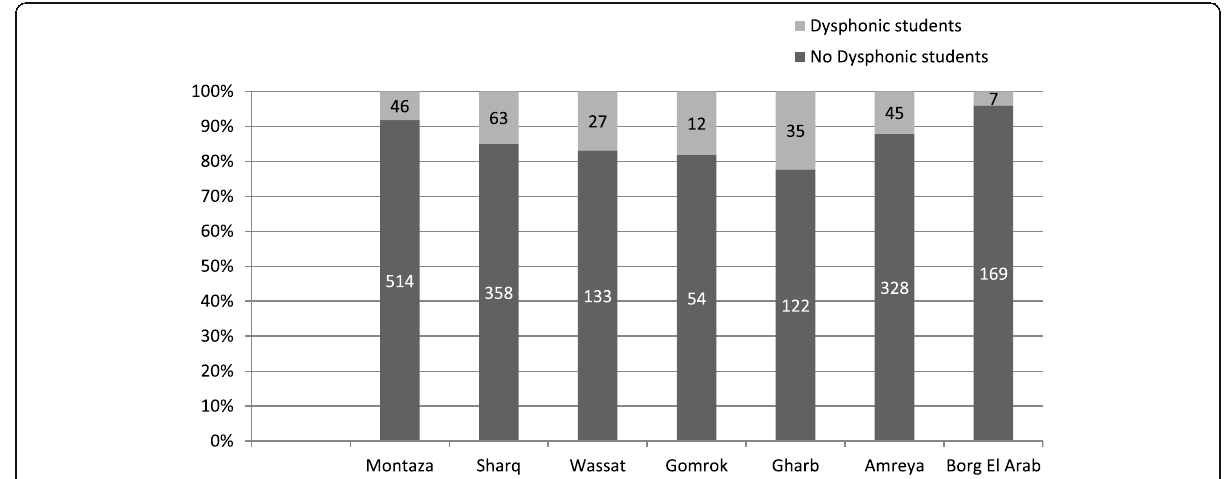
Figure 1 show the distribution of dysphonic and nondysphonic students in each 7 Alexandria Educational